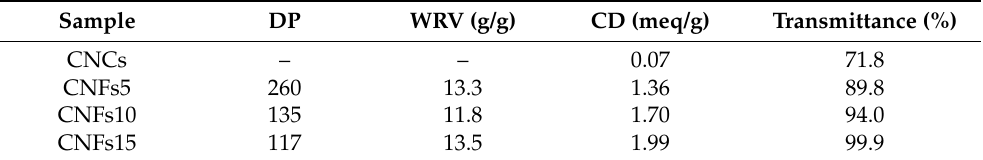
Table 3. Key characteristics of CNCs and CNFs: degree of polymerization (DP), water retention value (WRV), charge density (CD), and transmittance at 600 nm. Sample DP WRV (g/g) CD (meq/g) Transmittance (%) CNCs